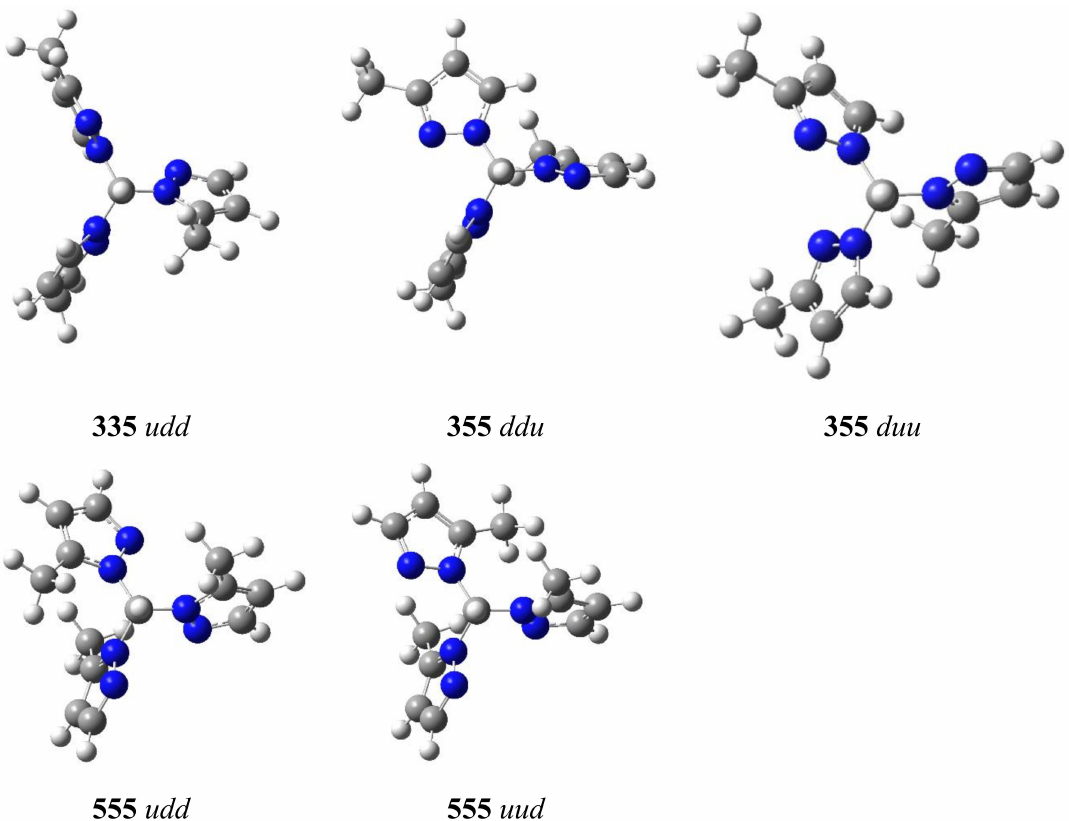
Figure 8. The most relevant calculated structures (the geometries of all the structures are to be found in the ESI). Table 5. Energies (kJ · mol –1 ). The minimum energy conformation in black; the crystallographic structure, TUYZEU, in